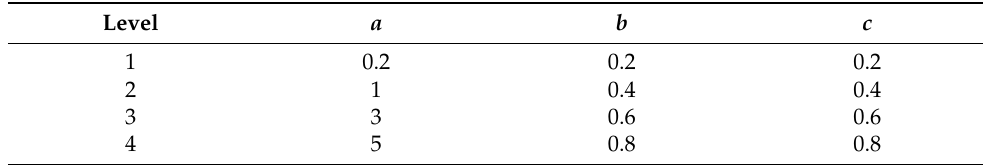
Table 4. Orthogonal test levels under single loads.